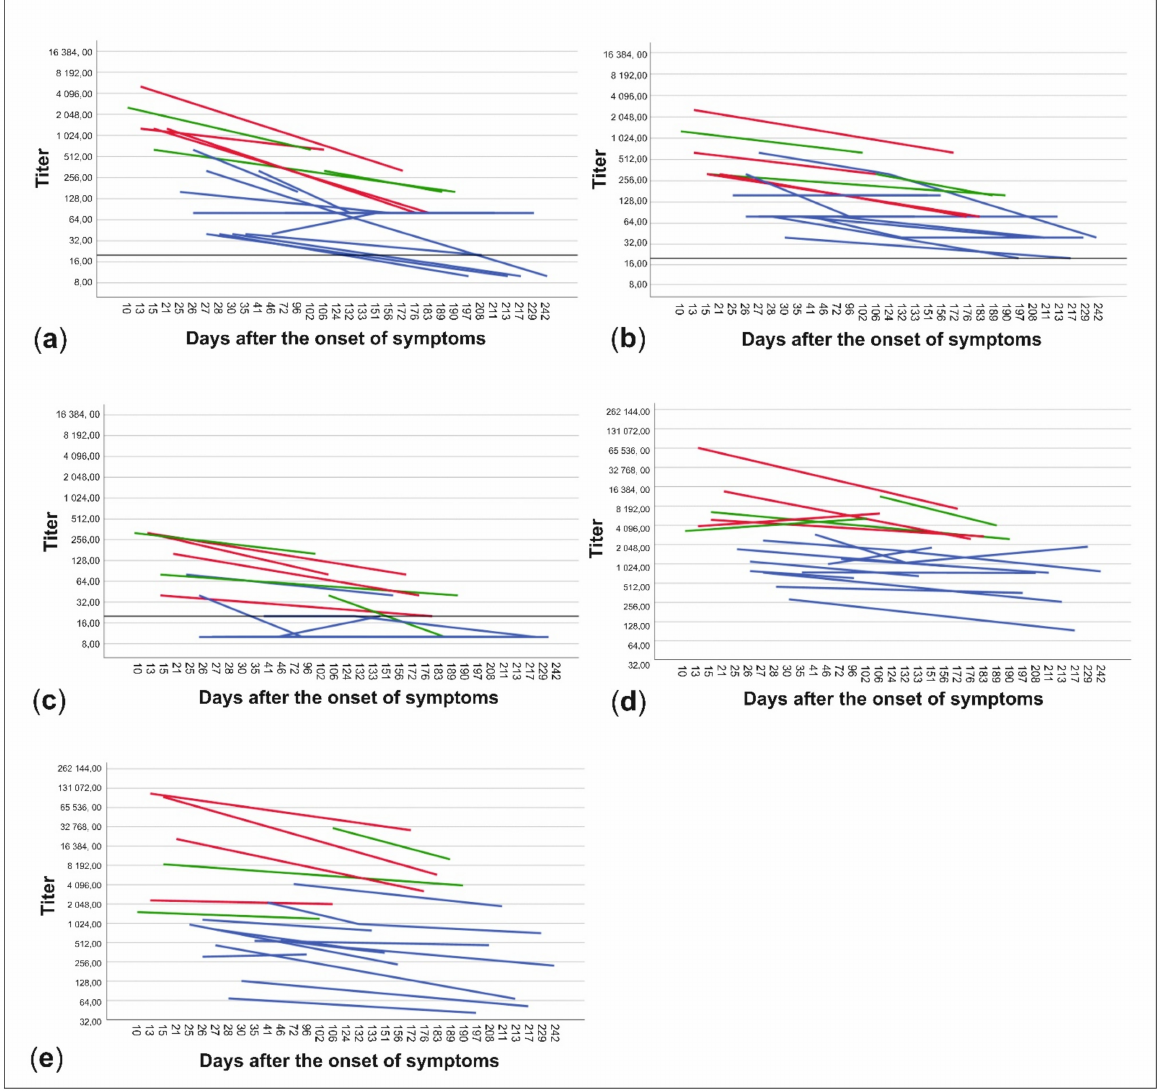
Figure 3. Changes in neutralizing antibody titers and anti-spike- and anti-NP-IgG titers between samples of each patient. Titers are expressed as neutralizing antibody titers for C1P1 ( a ), VoC1 ( b ), and VoC2 ( c ) as well as end-point titers for anti-spike- ( d ) and anti-NP-IgG ( e ) antibodies. Patients treated at home are shown in blue and patients treated in the hospital are shown in red (non-ICU) and green (ICU). Titers are depicted in logarithmic scale (Log2), LOD has been marked with a horizontal line, and titers below LOD in A-C have been set to